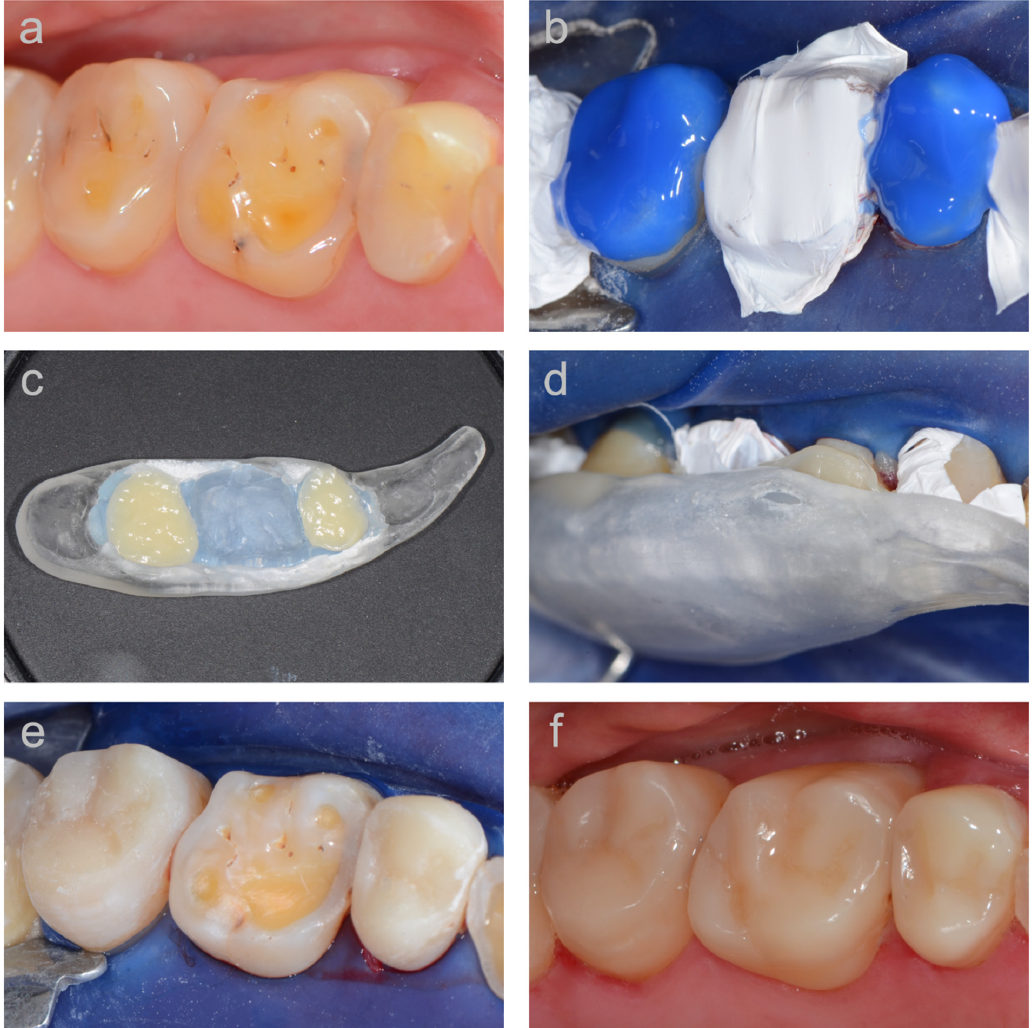
Figure 1. Step-by-step documentation of the TACS-technique (‘Template-Aided Composite Shaping’) used for the direct composite vertical bite reconstructions. ( a ) View of the eroded teeth before treatment; ( b ) adhesive pretreatment of every second tooth and isolation of the adjacent teeth with Teflon tape to avoid interproximal blocking with composite material; ( c ) detailed view of the wax-up-based short quadrant template made of transparent acrylic and relined with transparent bite registration material. The template is placed on a heating plate to preheat the composite inside the template; ( d ) template, filled with uncured composite, positioned on the tooth arch; ( e ) composite build-ups of teeth 15 and 17 after pre-finishing; ( f ) completely reconstructed occlusal surfaces of teeth 15–17 after finishing and polishing.